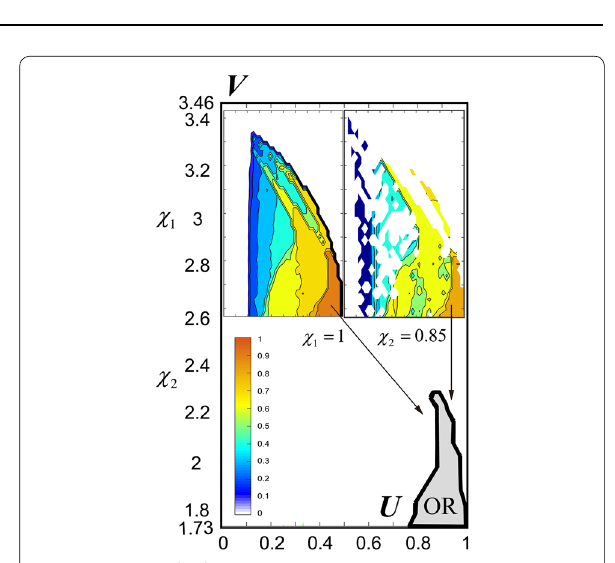
Figure 8 Optimal